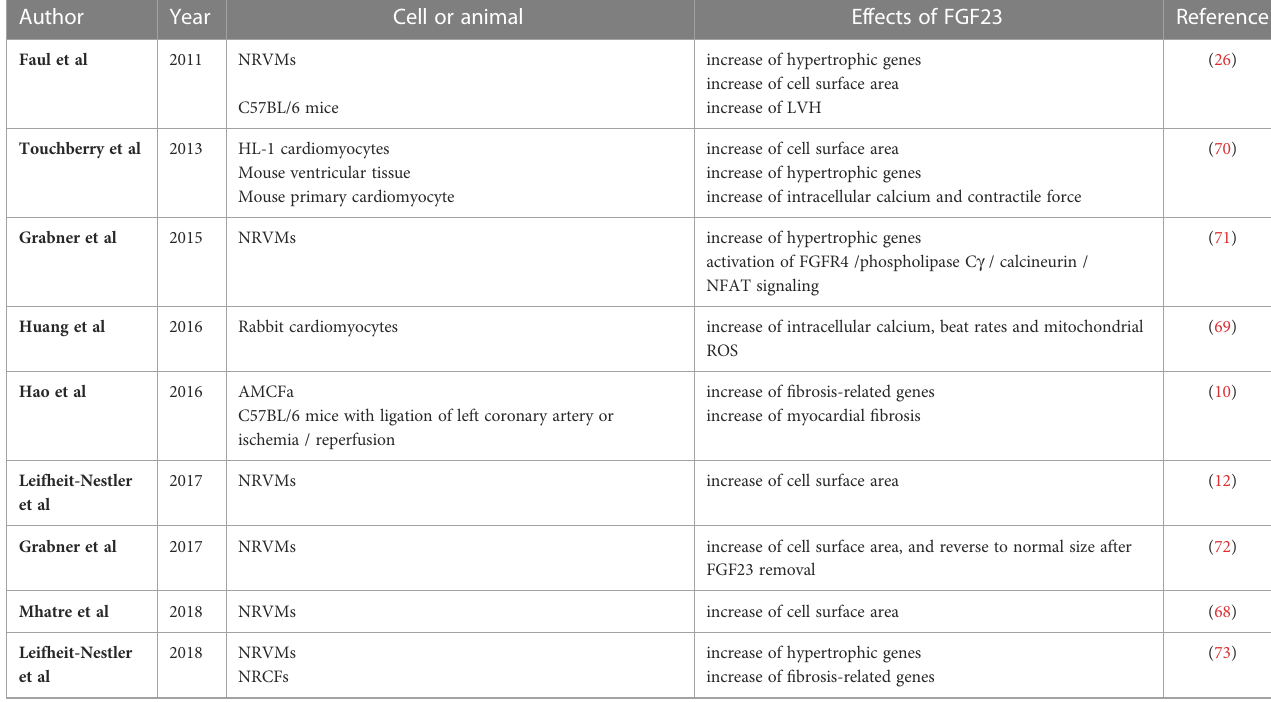
TABLE 1 Summary of the results of experimental studies regarding the direct effects of FGF23 on LVH and myocardial fi brosis.